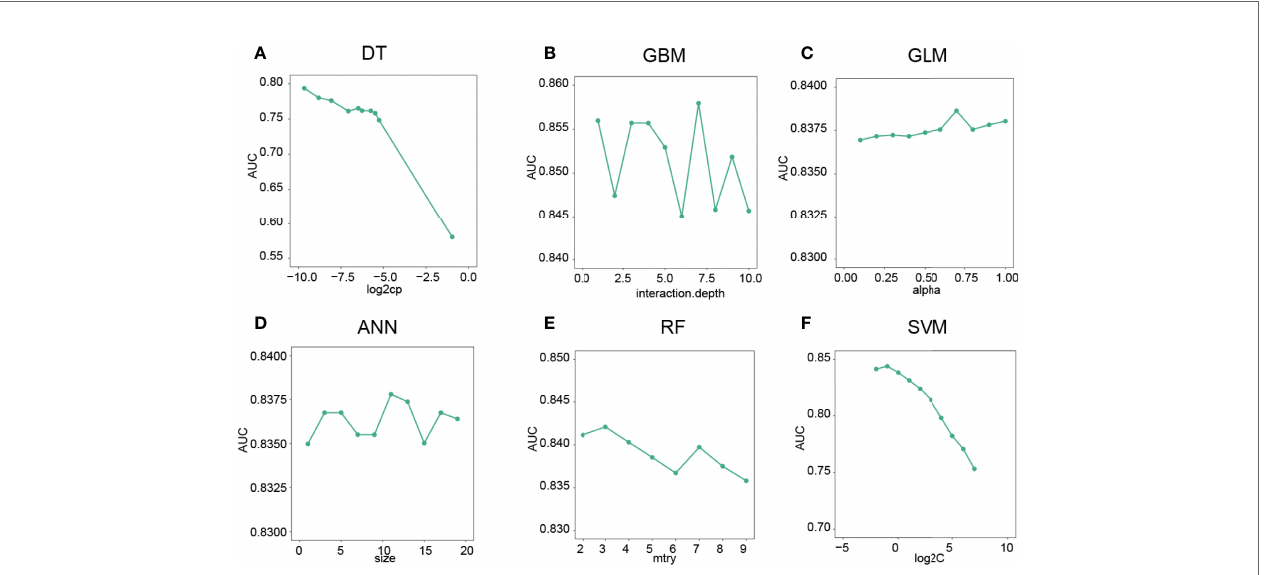
FIGURE 4 | Optimal parameter selection for machine learning models. (A) The “ log2CP ” and corresponding AUC values of the DT algorithm. (B) The “ interaction depth value ” and corresponding AUC values of the GBM algorithm. (C) The “ alpha value ” and corresponding AUC values of the GLM algorithm. (D) The “ Size ” and corresponding AUC values of the ANN algorithm. (E) The mtry ’ and corresponding AUC values of the RF algorithm. (F) The “ log2C ” value and corresponding AUC values of the SVM